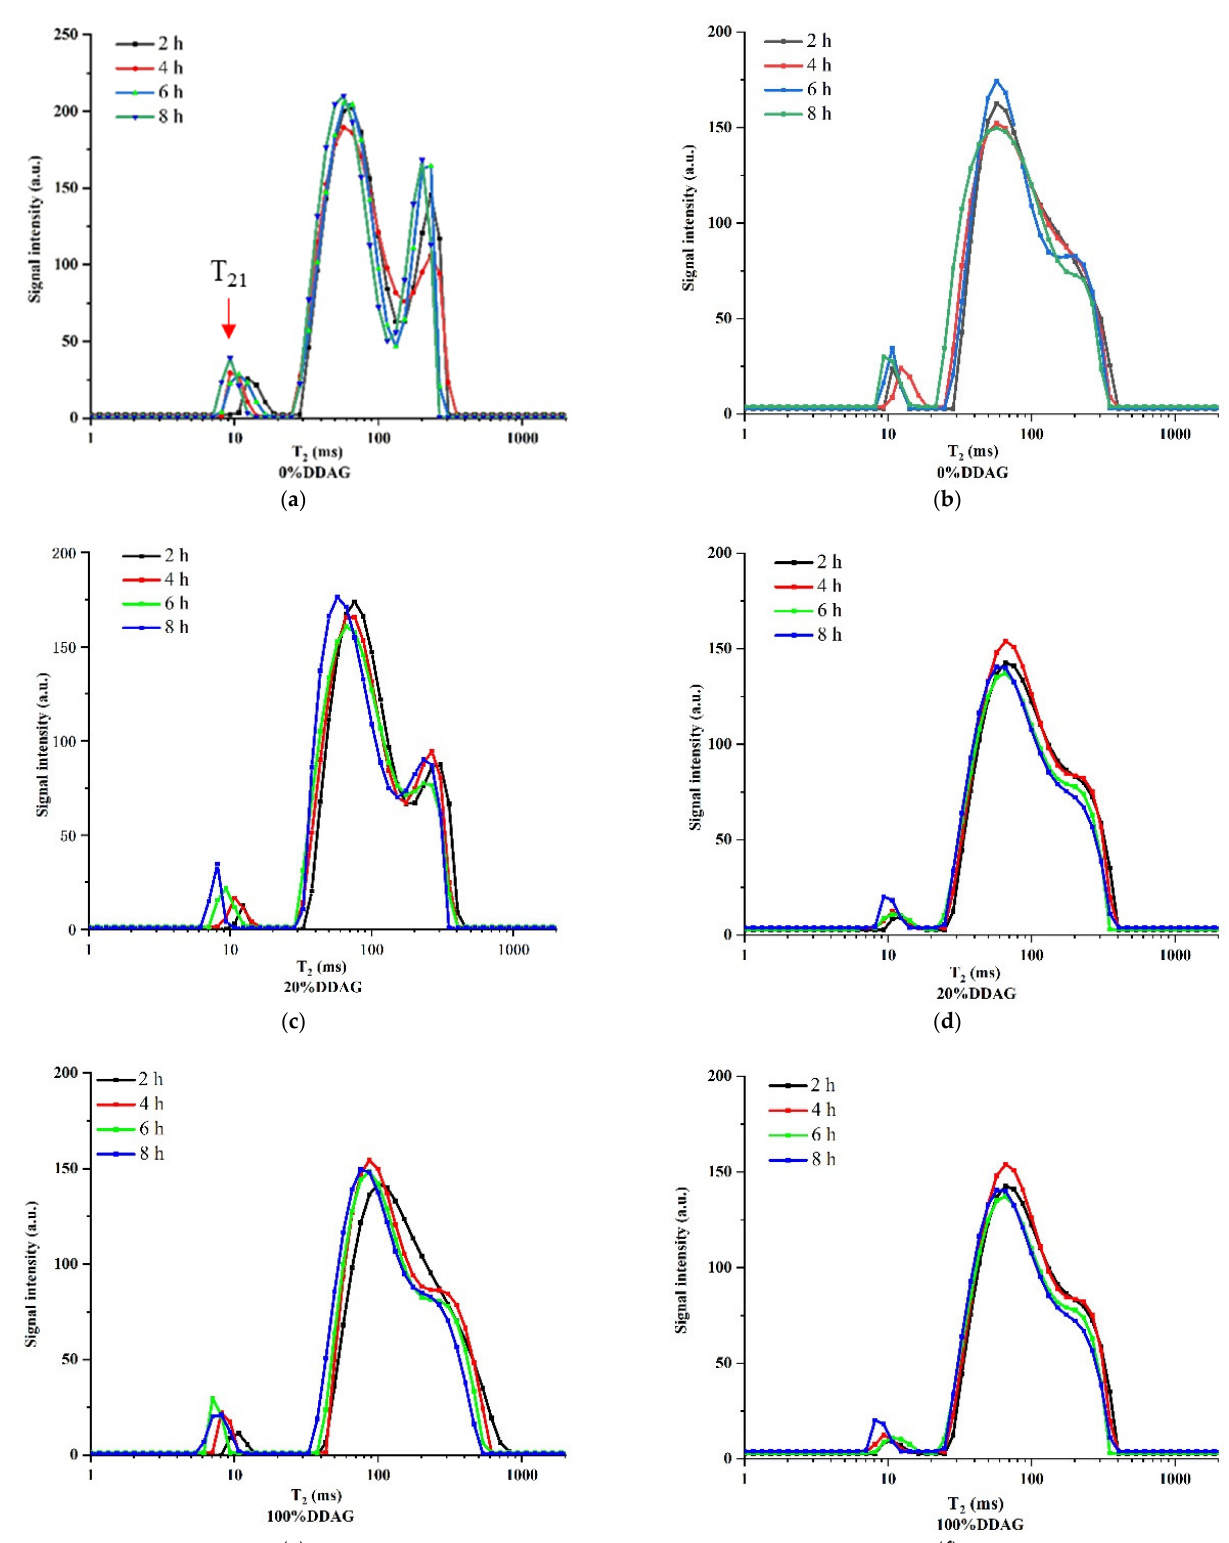
Figure 2. The LF-NMR transverse relaxation time curves of different DDAG concentrations of duck oils during ordinary heating (left) and HVEF heating (right) at 180 °C. ( a , b ) 0%DDAG; ( c , d ) 20%DDAG; ( e , f ) 100%DDAG.